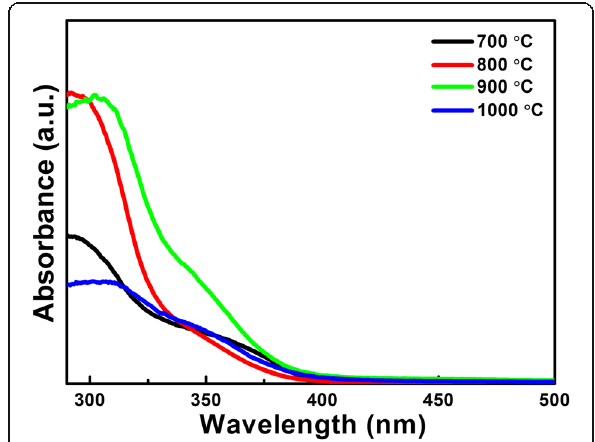
Fig. 3 UV-vis diffuse reflectance absorbance spectra of LiNb